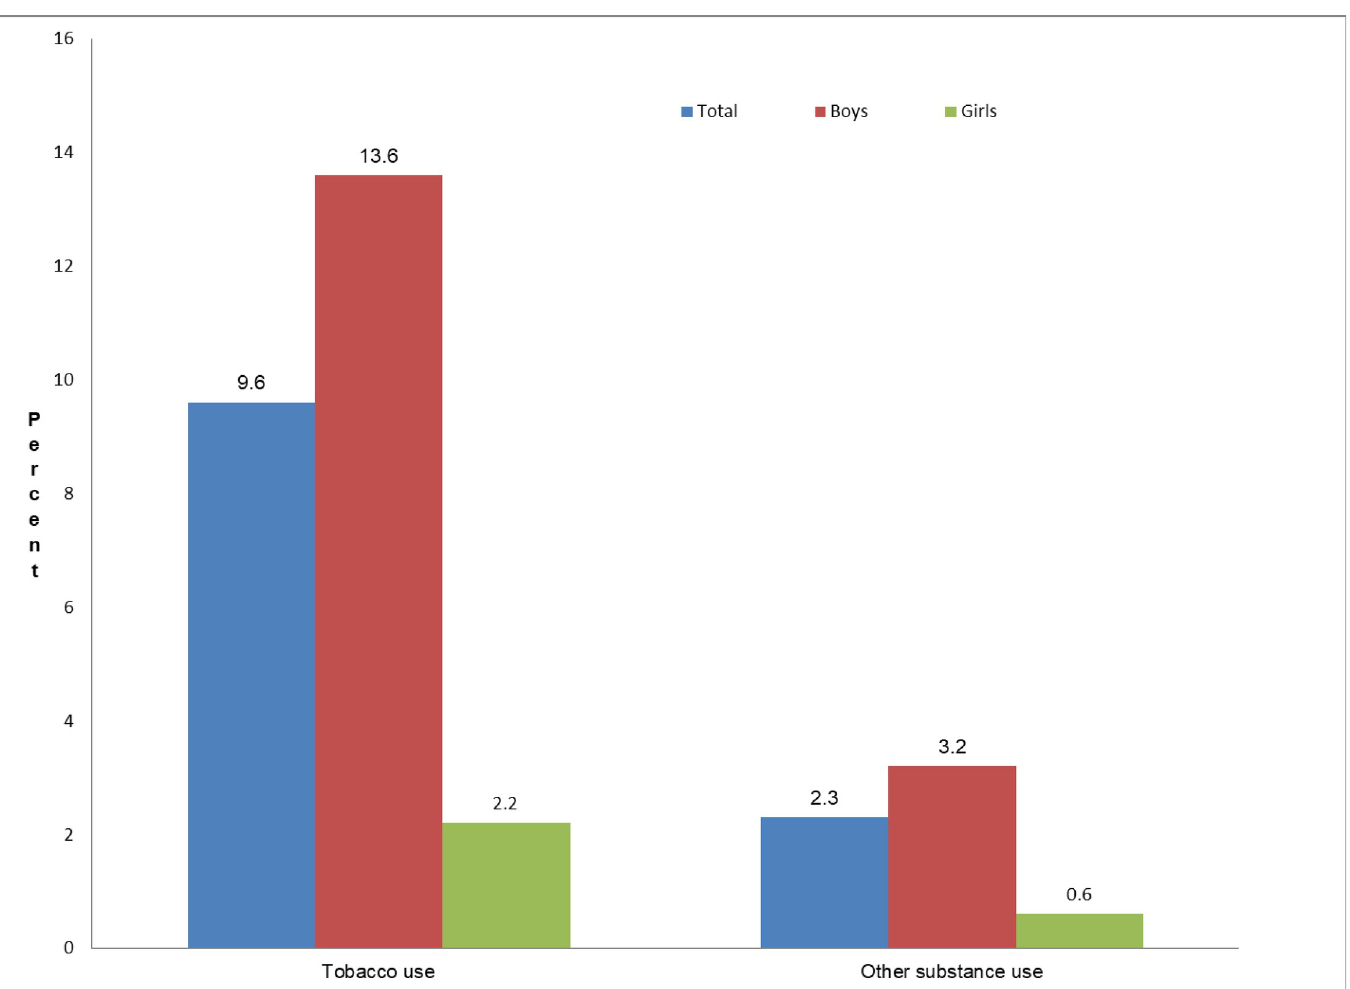
Fig 1. Prevalence of tobacco and other substance use among adolescents by gender, the 2014 Global School-based Student Health Survey (GSHS), Bangladesh.